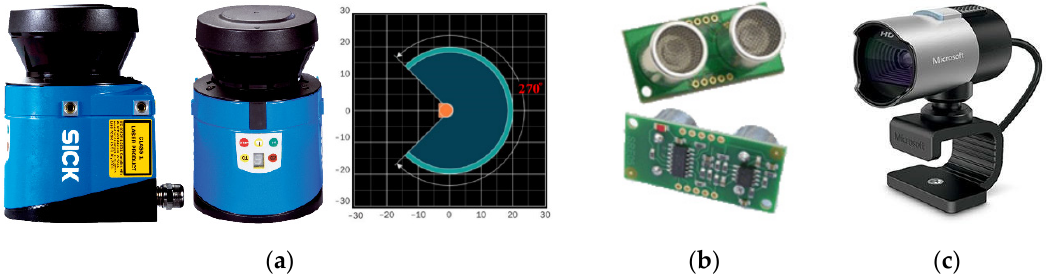
Figure 2. ( a ) The appearance and the scanning range of the SICK LMS 100 2D laser scanner [14]; ( b ) Microsoft LifeCam studio webcam [15]; ( c ) Devantech SRF05 sonar sensor module.